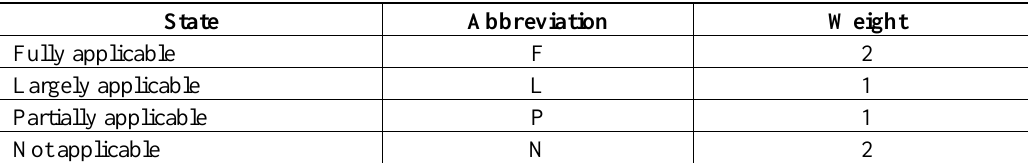
Table 1. Control question states and their